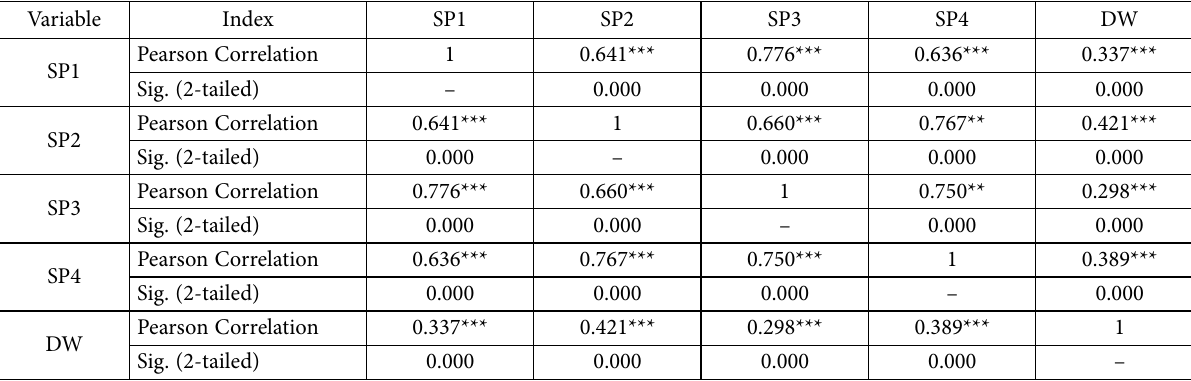
Table 15. Correlation analysis of supply-side policy and the developers’ willingness to implement PB